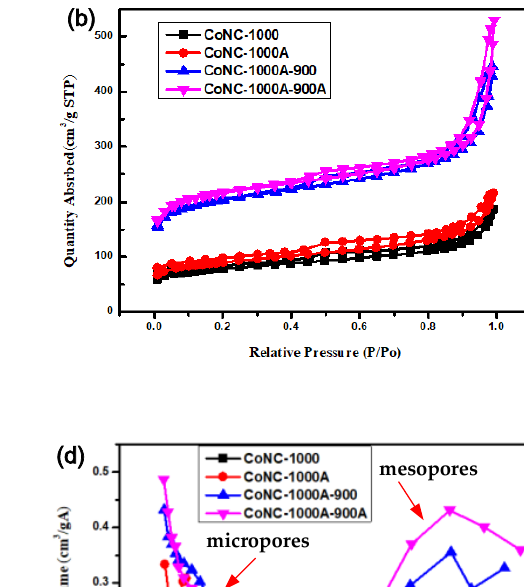
10 of 18 Figure 4. X-ray diffraction patterns of Co-N-C catalysts ( a ) treated at 1000 o C ( b ) and with two-stage calcination double acid leaching. 3.4. BET Surface Area and Pore Size Distribution The BET surface area significantly increased to more than 450 m 2 g − 1 (Figure 5a) after the second calcination, which was performed at a temperature 100 °C less than the first calcination in order not to devastate the structure created in the first calcination. A larger amount of ammonia gas compared to N 2 than that applied in the first calcination was mixed with N 2 gas in the second calcination to create more and larger pores on the surface of Co-N-C catalysts by efficient bombardment [16,17,19]. This eventually caused a signif- icant increase in surface area, with more mesoporous pores, as presented in the second column of Table 2. The pores newly created in the second calcination demonstrate meso-